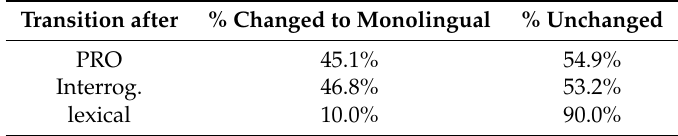
Table 2. Results of memory-loaded repetition task: mixed Quichua-Media Lengua stimulus utterances. Transition